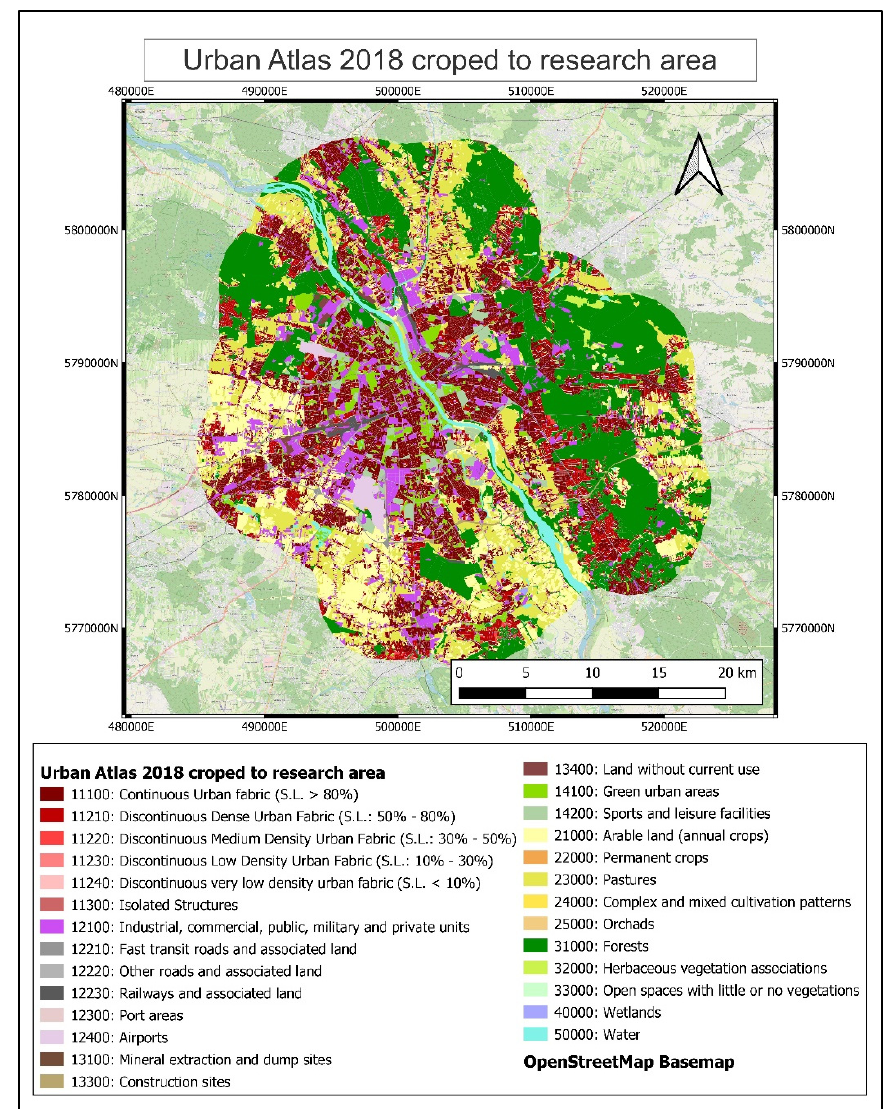
Figure 2. Urban Atlas 2018 cropped to the extent of the research area.